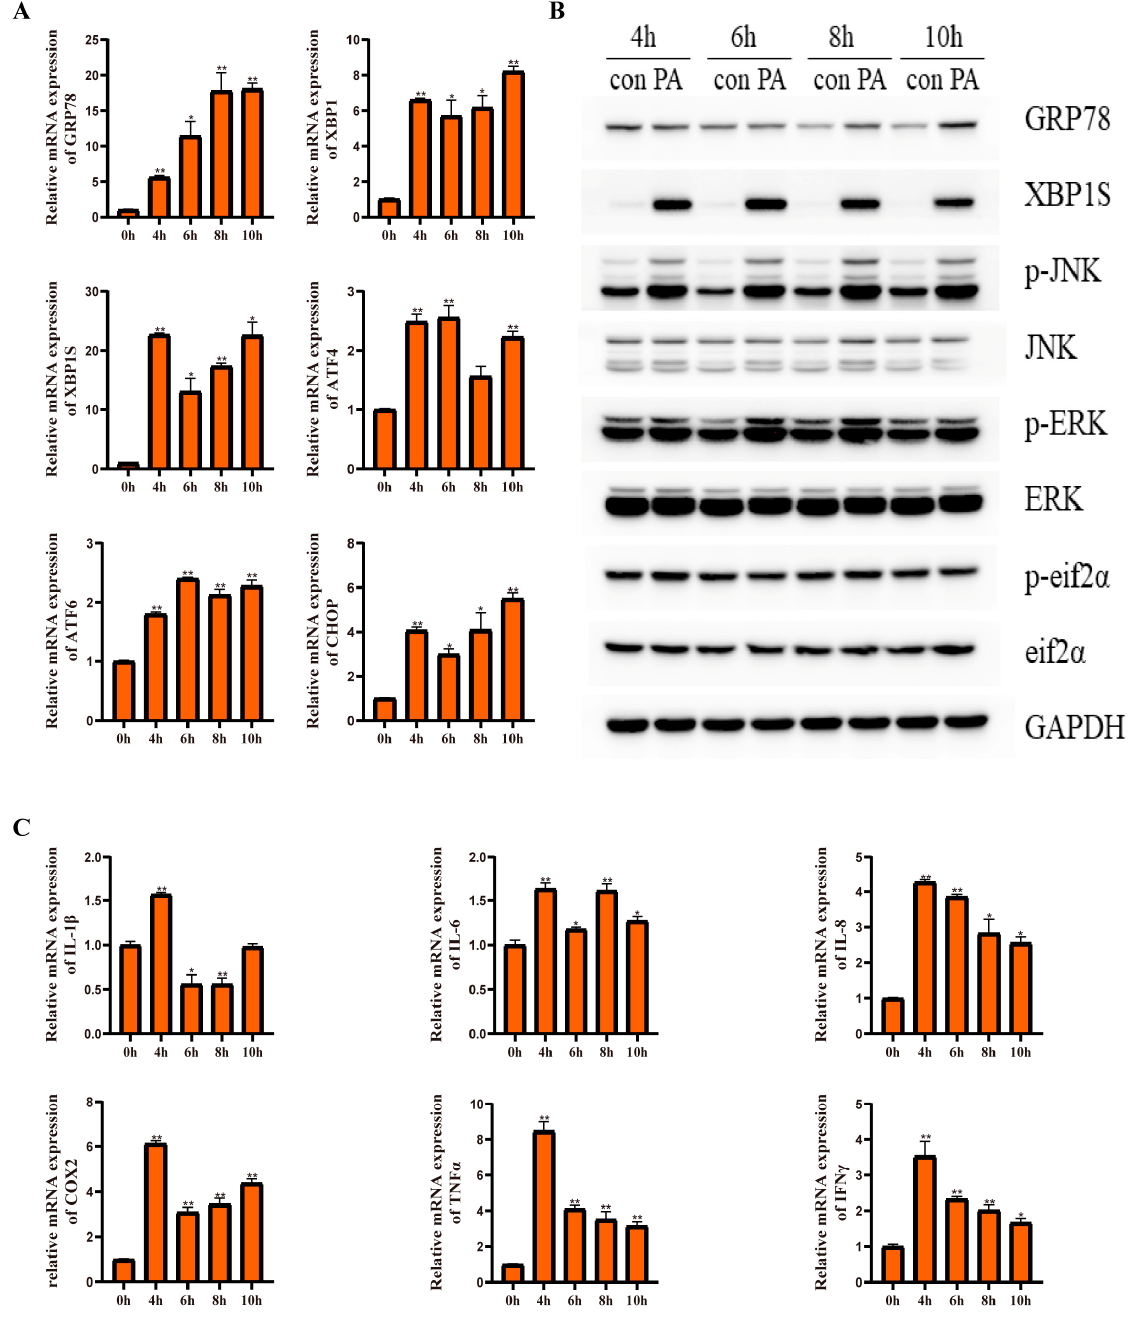
Figure 8. Effects of 500 µ M PA treatment on ER stress and inflammation in macrophages of large yellow croakers. ( A ) Relative mRNA expression of ER stress-related genes after PA treatment for different time points. ( B ) Protein levels of ER stress-related proteins and inflammatory-related proteins after PA treatment for different time points. ( C ) Relative mRNA expression of inflammatory genes after PA treatment for different time points. Values are presented as mean ± SEM ( n = 3). * Significant difference ( p < 0.05); ** highly significant difference ( p < 0.01).